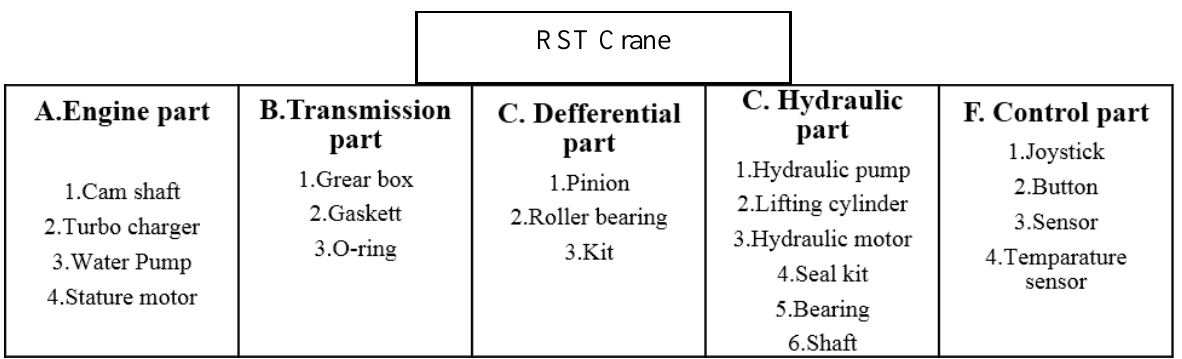
Figure 5. Block Diagram of RST Crane